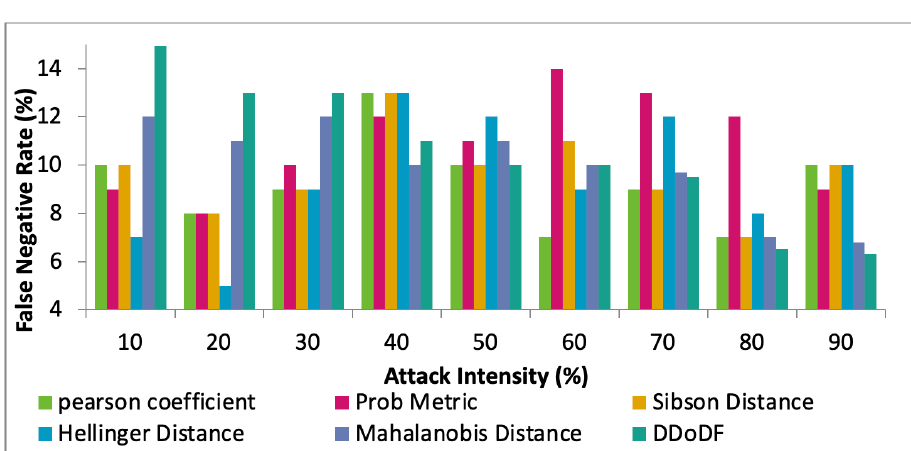
Figure 11. Attack intensity vs. false-positive rates.